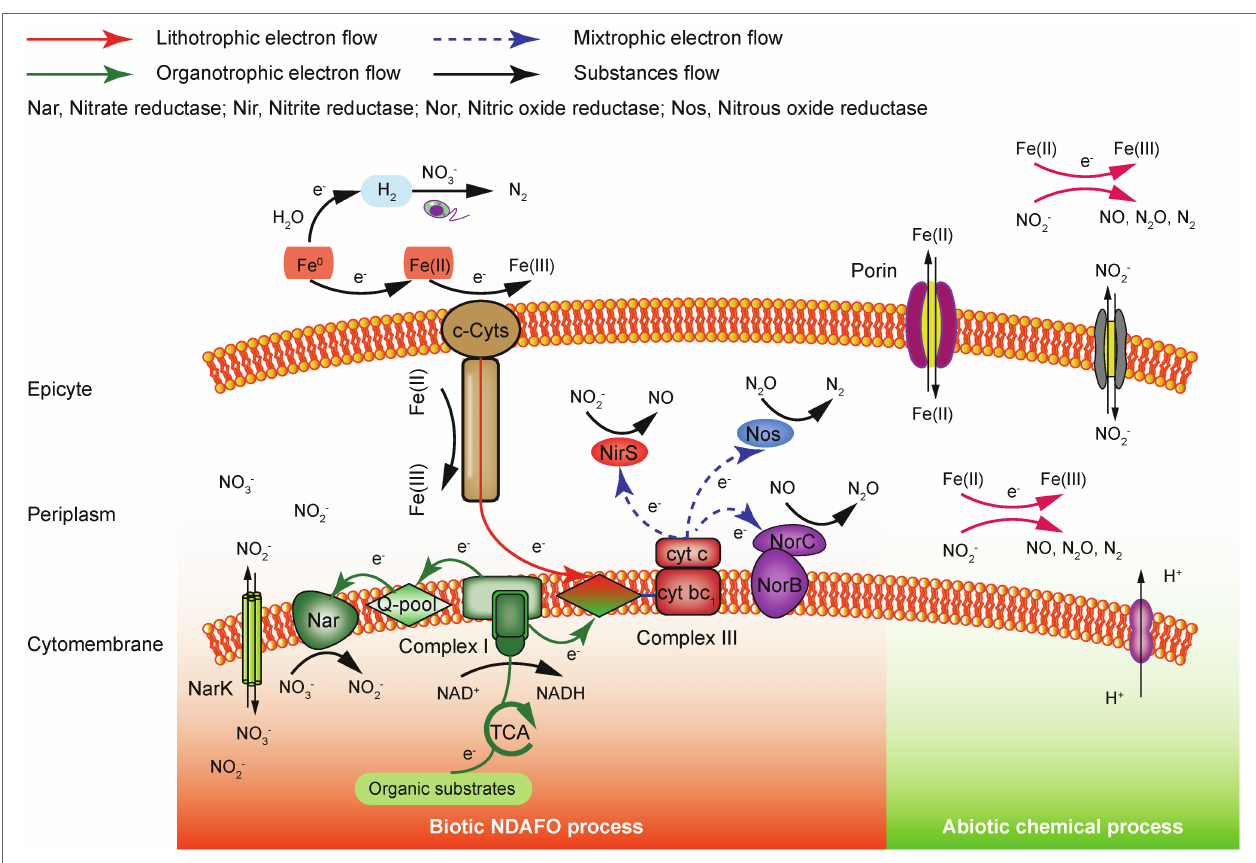
FIGURE 1 | Electron transfer mechanism of the ZVI/Fe(II)-supported NDAFO process (Zhang et al.,